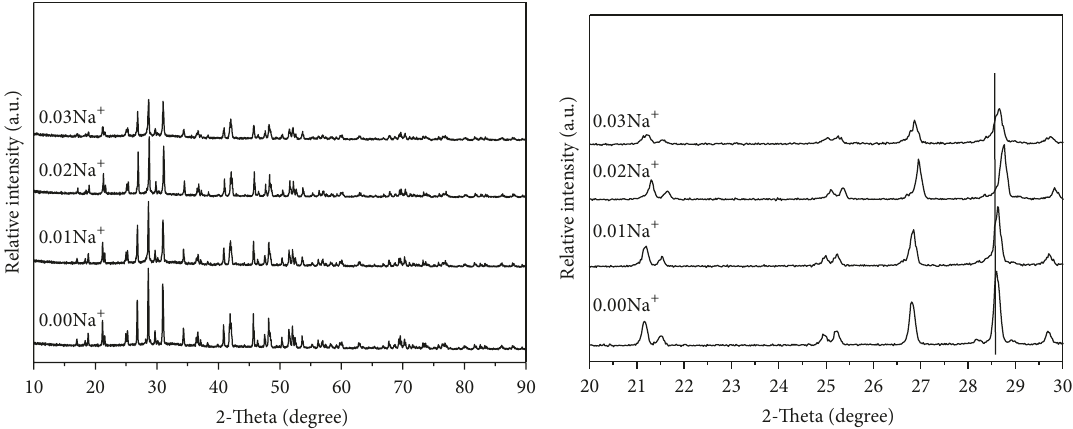
Figure 2: XRD patterns of La 0.97 PO 4 :Bi 3+ 0.03 , Na + y (y = 0.00,0.01,0.02,0.03 ) samples calcined at 1200 ∘ C for 8 h. - y